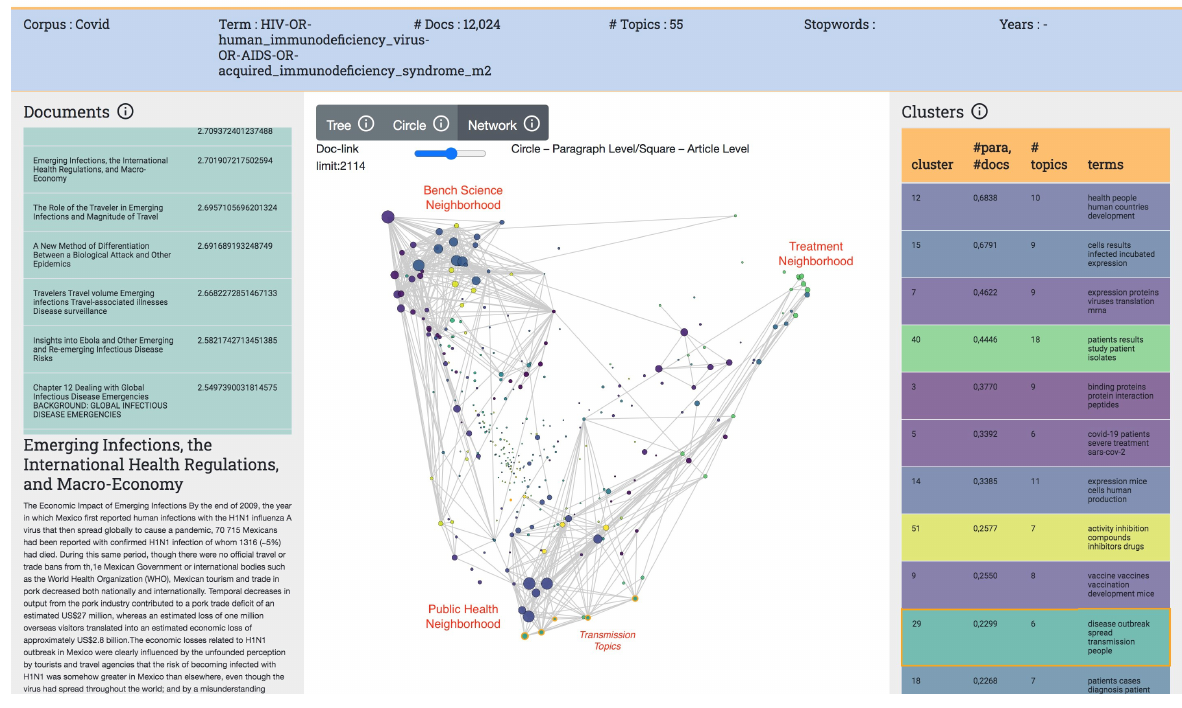
Figure 8. Network visualization of the HIV Topic